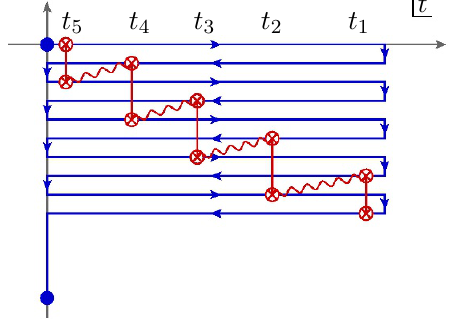
Figure 4 . Illustration of the arrangement of operators in our 2 k -point observable F 2 k , for the case k = 5. It provides a generalization of the familiar 4-point OTOC, which has the property that the associated time of exponential growth (which we call as k -scrambling time t ( k ) (cid:3) ) is maximal: t ( k ) (cid:3) = ( k (cid:0) 1) log c . The red solid lines indicate bilocal operators B schematically indicate the (maximally braided) propagation of the scrambling mode (cid:15)